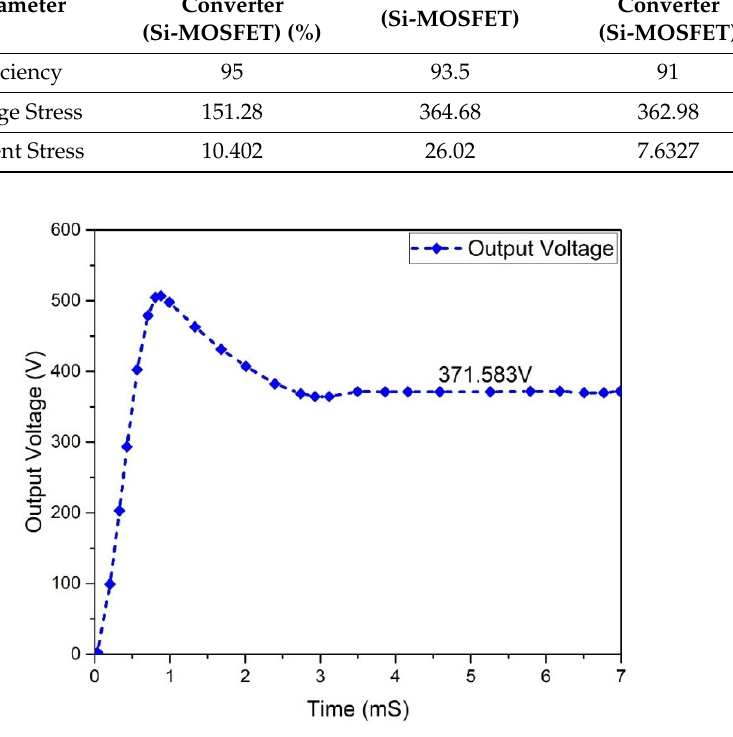
Figure 7. Flyback boost converter output voltage.